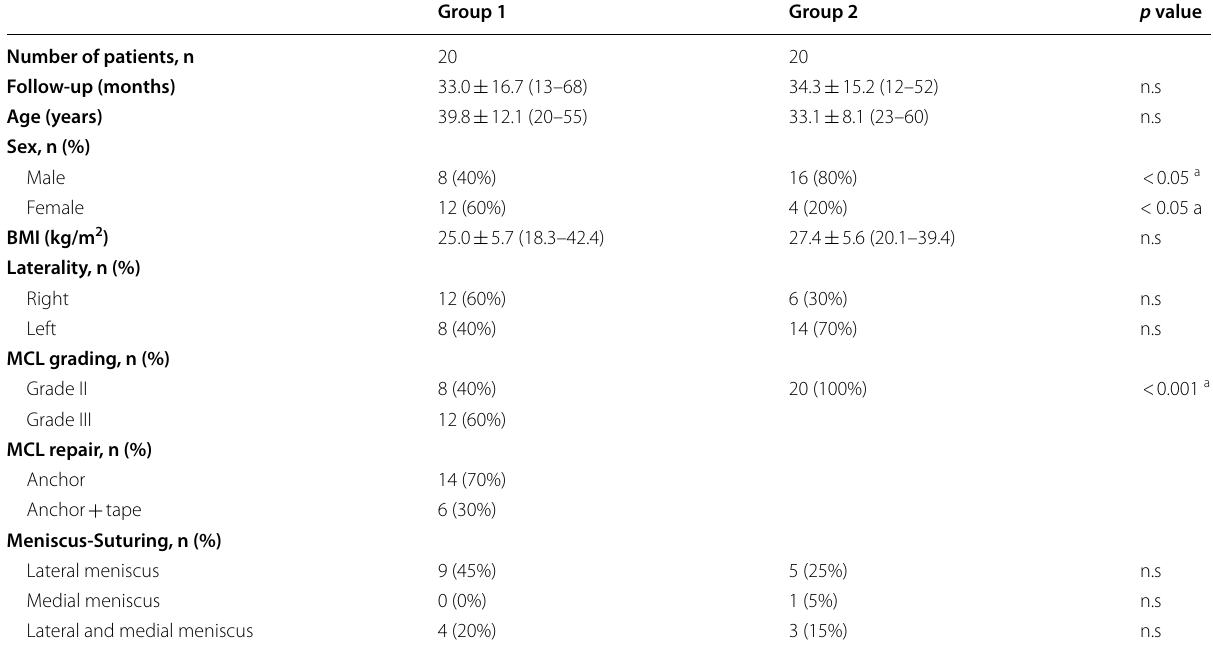
Table 1 Patient demographics of the total study group. Continuous variables are shown as mean categorical variables are shown as percentages